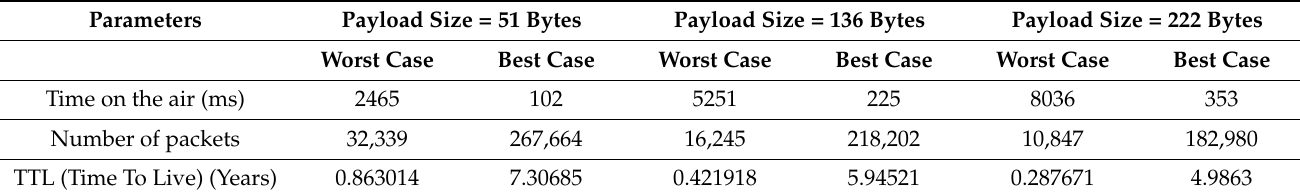
Table 8. Battery lifetime in the case of the original LoRaWAN with authentication for different message sizes.